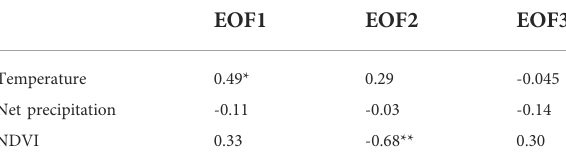
TABLE 2 The correlation between the time coef fi cient of EOF modes and climate factor.